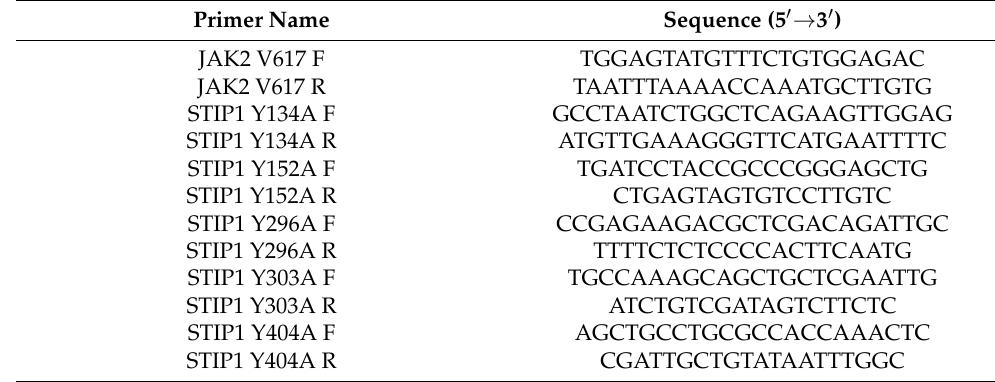
Table 1. DNA sequences of the primers used to generate constructs harboring point